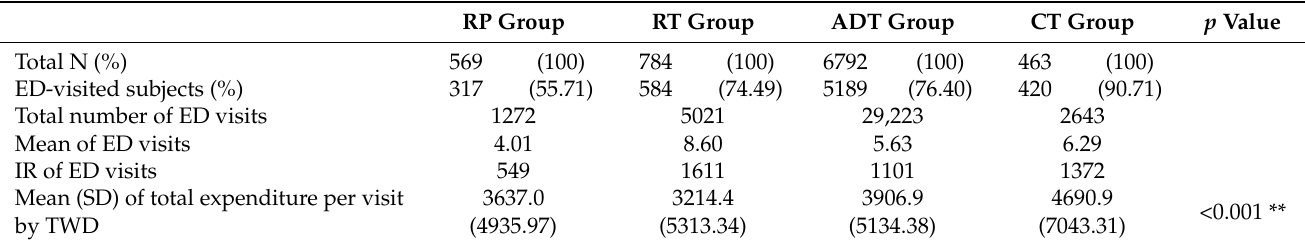
Table 2. Utilization of emergency department according to different treatment of prostate